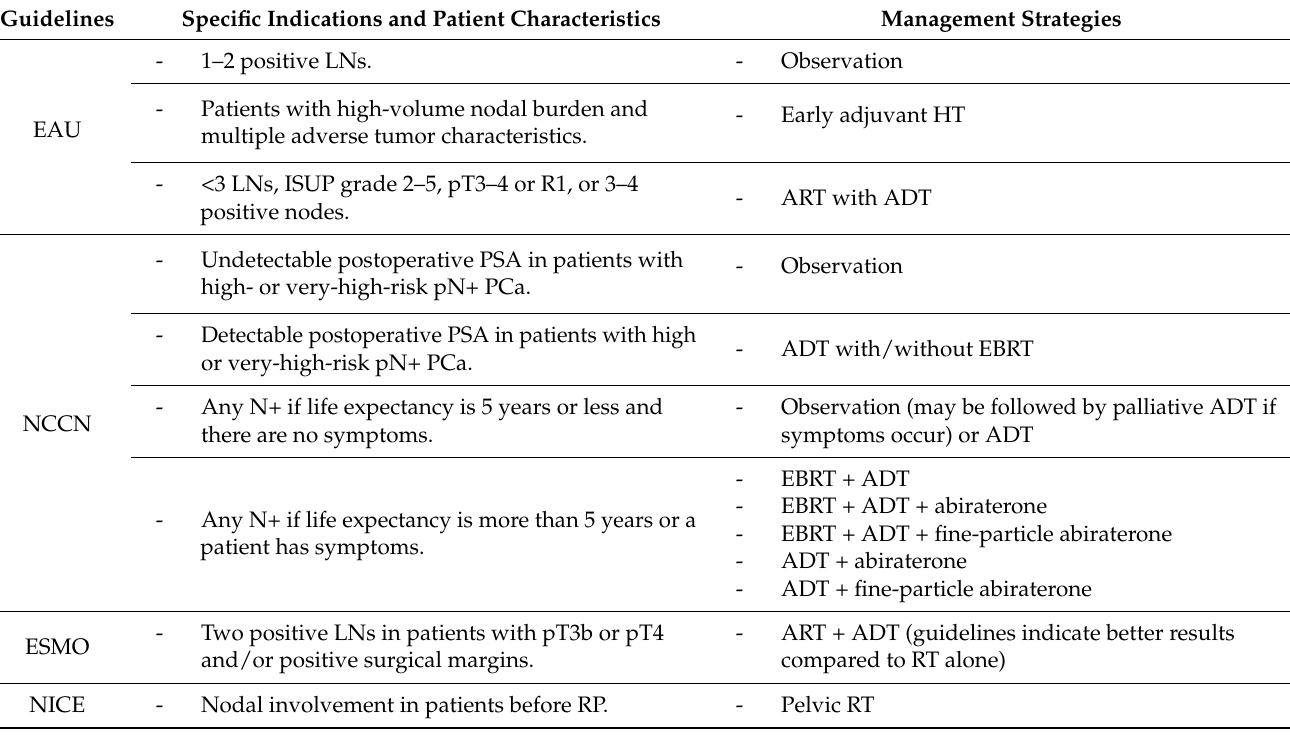
Table 1. Overview of N+ patient management strategies according to guidelines provided by the EAU, the NCCN, the ESMO, and the